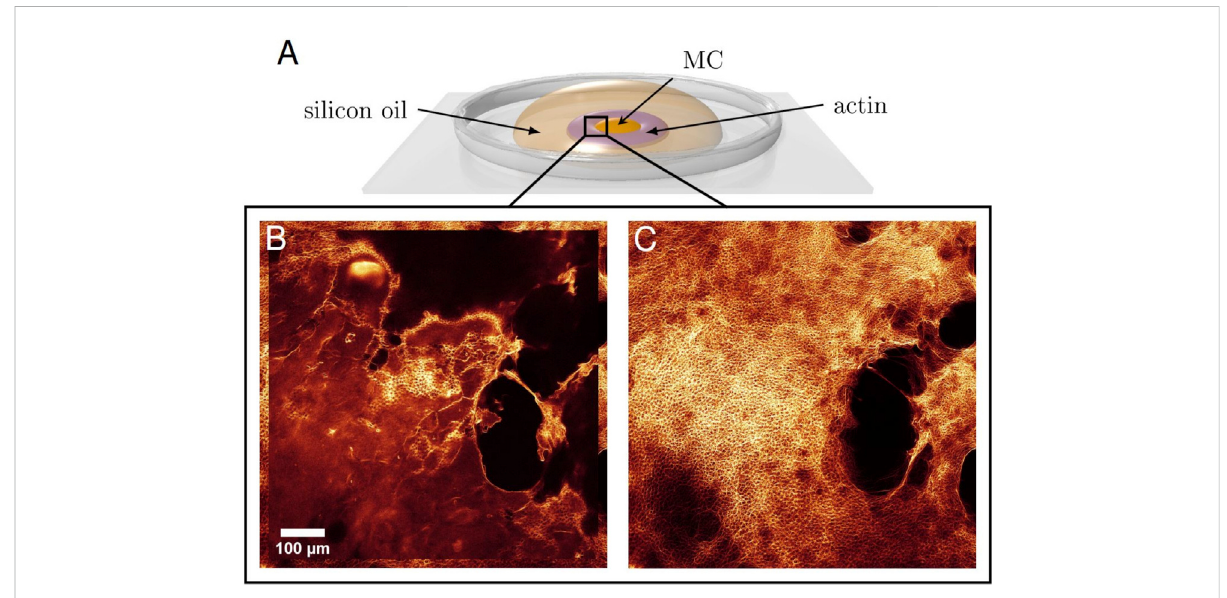
FIGURE 1 (A) DropletDeposition.Directlyafterinitializingthepolymerisationofactin fi laments,thesolutionwascarefullypipettedaroundadropletofMC. A silicon oil layer on top prevented evaporation. Diffusion of actin fi laments and MC built up a concentration gradient. Thus, polymerisation and bundling were temporally separated. An isotropic polymer distribution is necessary for asters to form. (B) Formation of the aster networks ~ 1 hour after the start of the experiment and (C) 4 hours later illustrate the time evolution of the system until reaching the fi nal